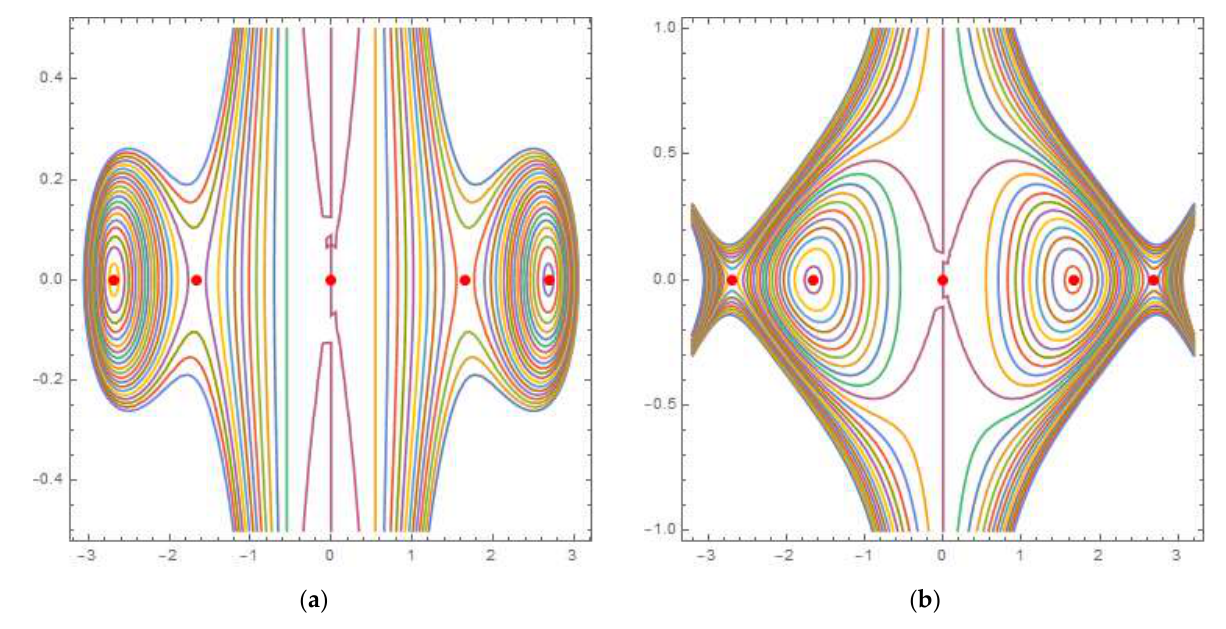
Figure 3. Trajectories of the dynamical system (17), where ( a ) 𝑎 1 = 1, 𝑎 2 = 0, 𝑎 4 = 0, 𝑞 −1, 𝑞 = 1; 𝛾 = −1, 𝛿 = 1, 𝛽 = 1 ; ( b ) 𝑎 3 1, 𝛽 = 1 .